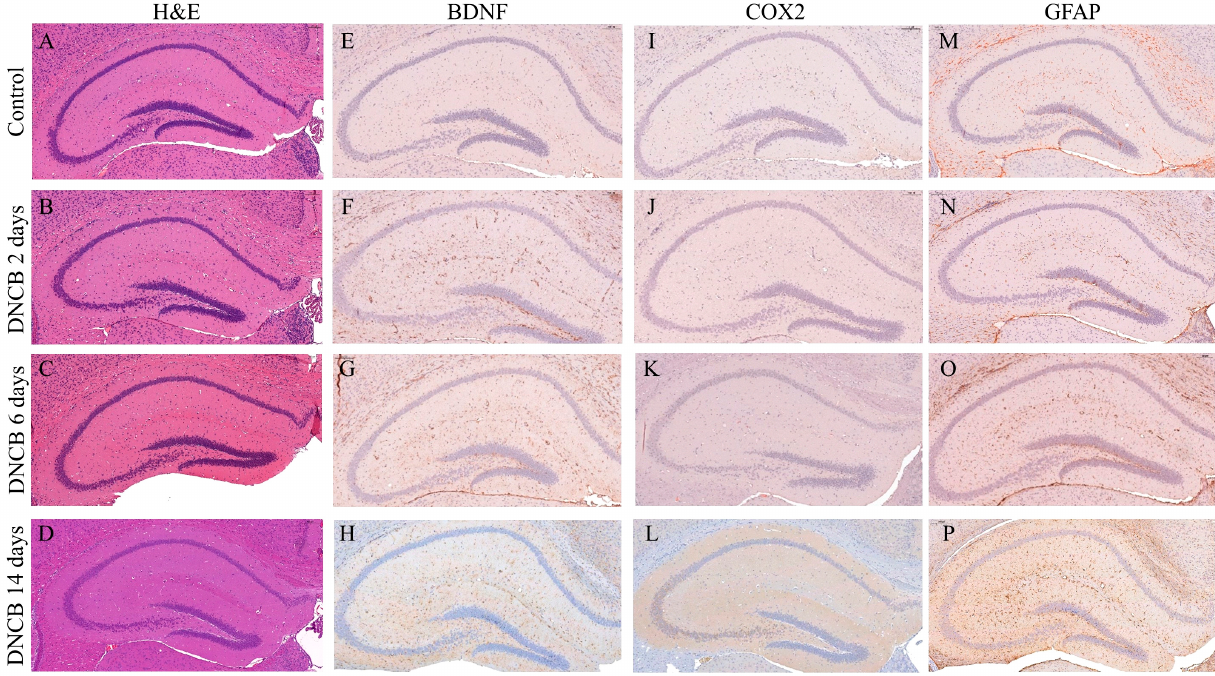
Figure 3. Atopic dermatitis altered the expression patterns of neuroinflammation markers in the hippocampus. Representative hematoxylin and eosin staining images of the hippocampus; ( A ) con- trol, ( B ) DNCB 2 days, ( C ) DNCB 6 days, and ( D ) DNCB 14 days. Immunohistochemical (IHC) stain- ing of brain-derived neurotrophic factor (BDNF) in the hippocampus; ( E ) control, ( F ) DNCB 2 days, ( G ) DNCB 6 days, and ( H ) DNCB 14 days. IHC staining of cyclooxygenase-2 (COX2) in the hippo-